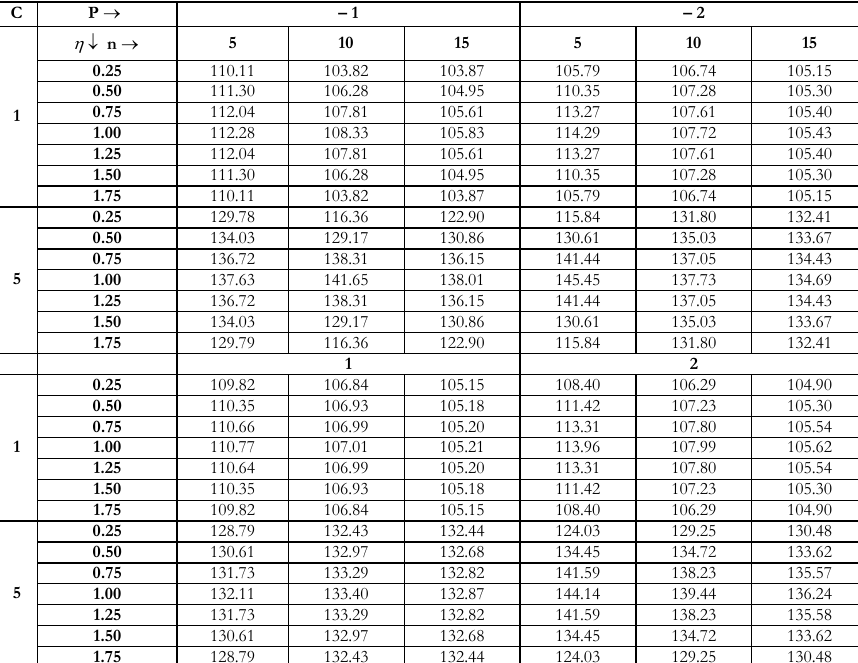
Percent relative efficiency of